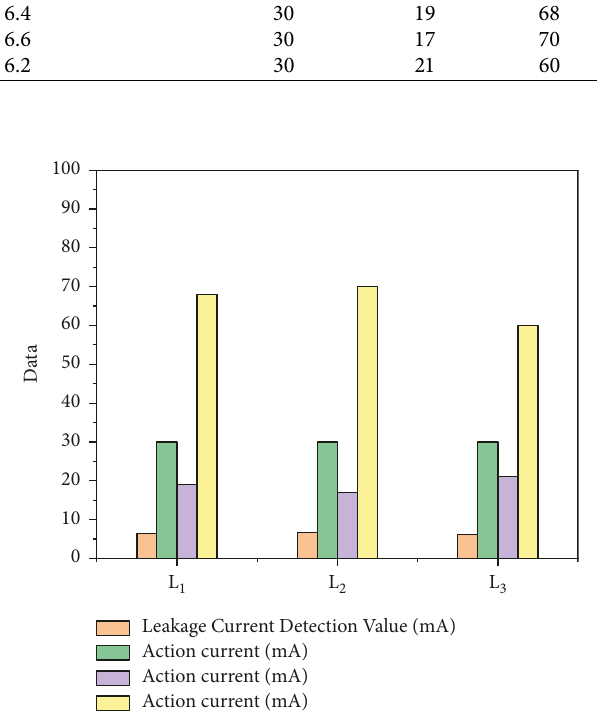
Figure 4: Data diagram of indirect contact leakage fault test results. Table 2: Test results of direct contact leakage